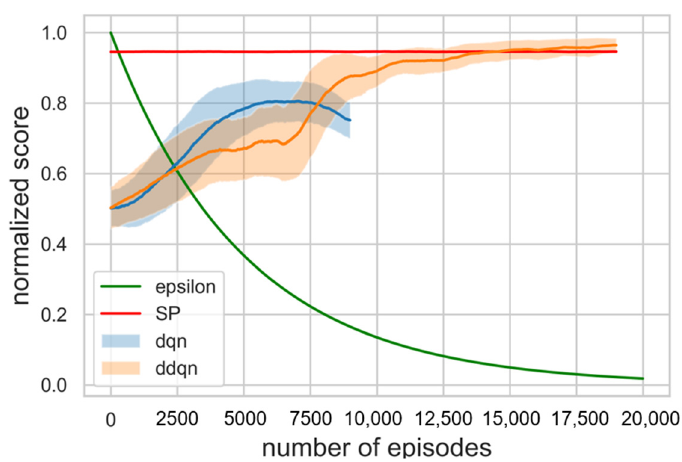
Figure 5. Learning curves during 20,000 episodes, comparing the results of the DDQN with the DQN and SP results. The cumulative sum of rewards obtained in each timestep of an episode, which is specified as a score, was used as the result indication.